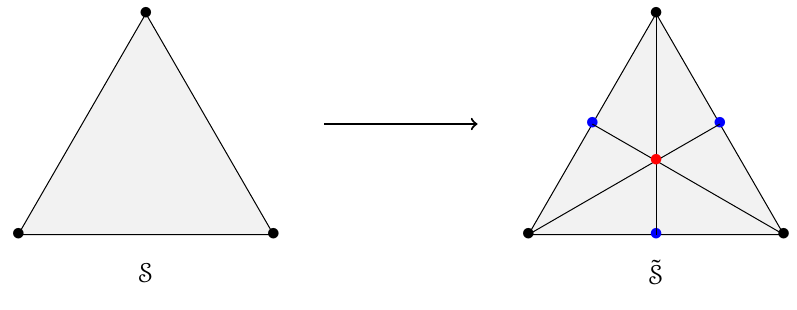
Figure 1: The construction of ˜ S for a 2-complex S